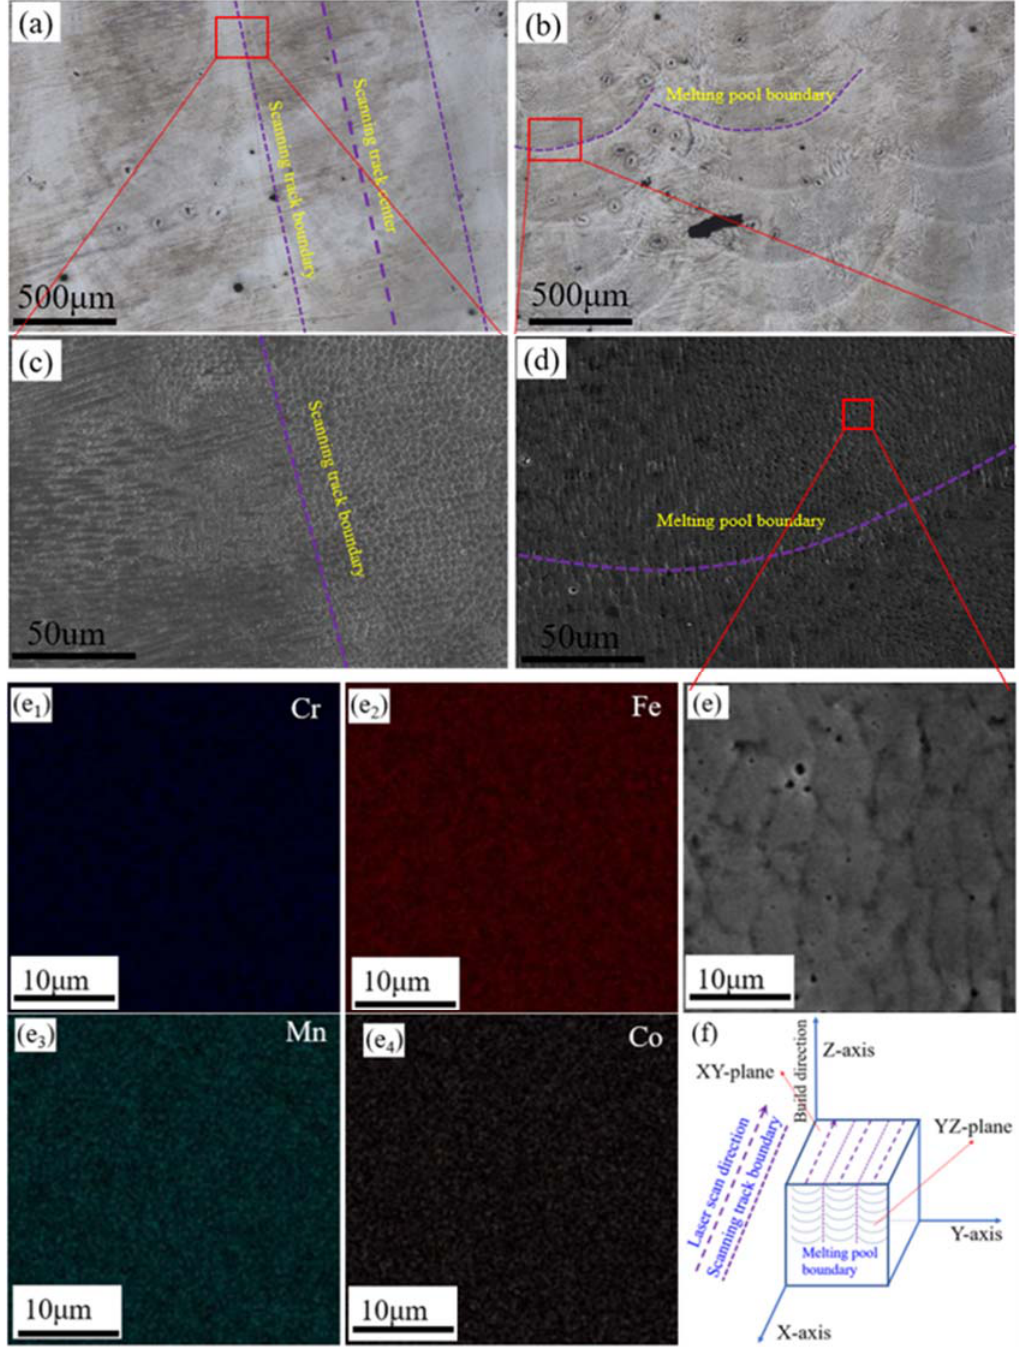
Figure 1. Microstructures and schematic diagram of the laser melting deposition (LMD) ‐ produced Fe 50 Mn 30 Co 10 Cr 10 HEA cube: ( a , b ) OM images of the XY ‐ and YZ ‐ planes; ( c , d ), SEM images of the XY ‐ and YZ ‐ planes; ( e , e 1 − e 4 ) SEM image and EDS mapping results of the corresponding area in ( d ); and ( f ) schematic diagram of the cube. Table 1. Detailed chemical compositions (at.%) of the Fe 50 Mn 30 Co 10 Cr 10 powder.